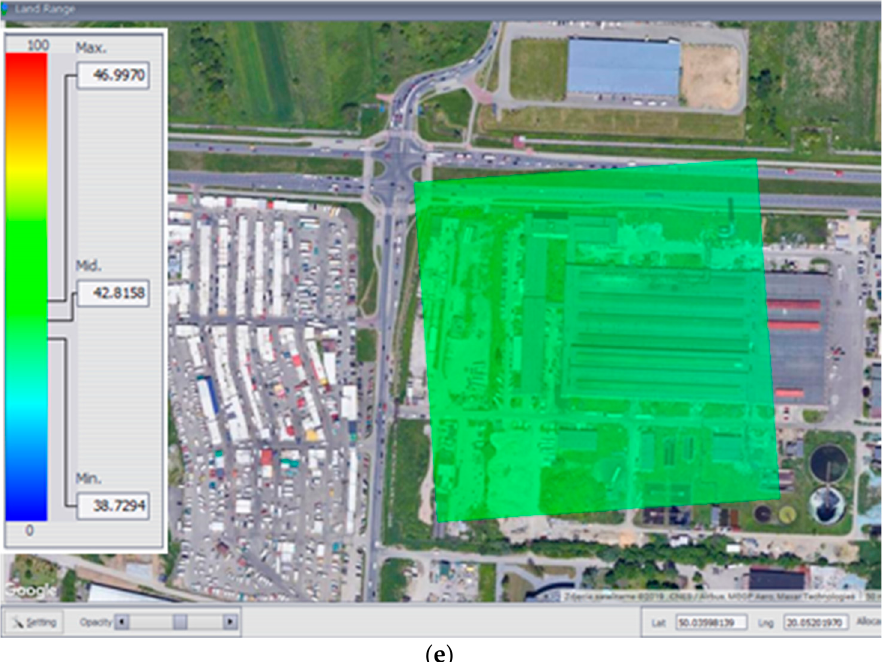
Figure 7. The value of the coefficient of area suitability for the location of a municipal waste incineration plant—( a – e ): Facility 1–5.